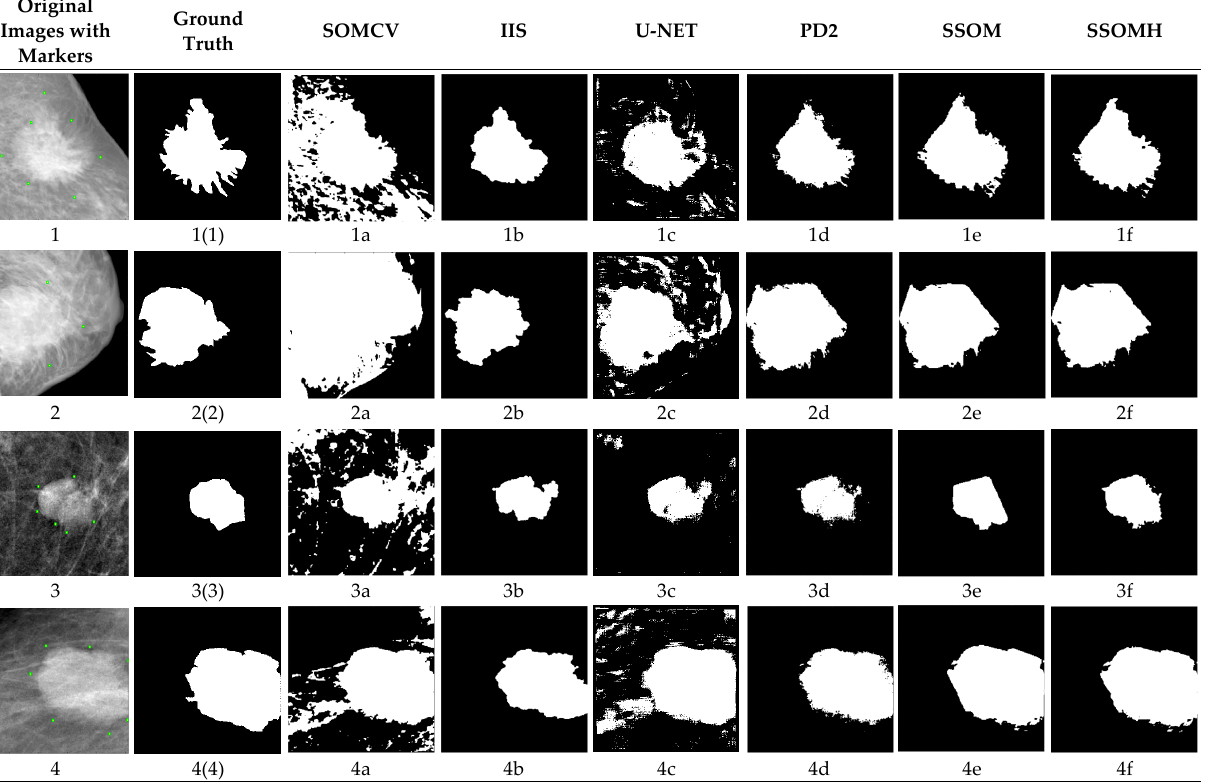
Figure 3. Segmentation Results of Four Samples of Test Images (INbreast Database) for the SOMCV, IIS, U-NET, PD2, SSOM and SSOMH Models.